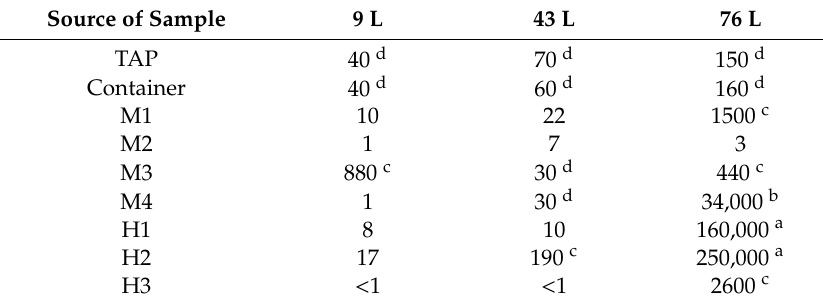
Table 5. Comparison of removal e ffi ciency of total bacteria count from tap water by ODTMA–bentonite granules after the first regeneration of the complex by passing dilute HCl solution (H) or by MW heating: number of emerging bacteria after passage of given volumes